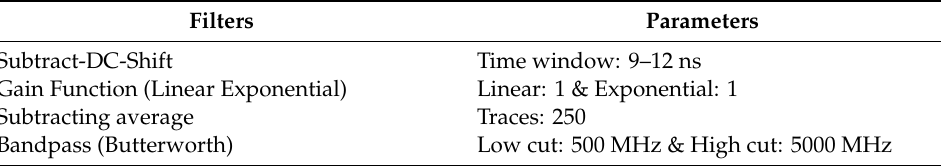
Table 2. Filters used for GPR data